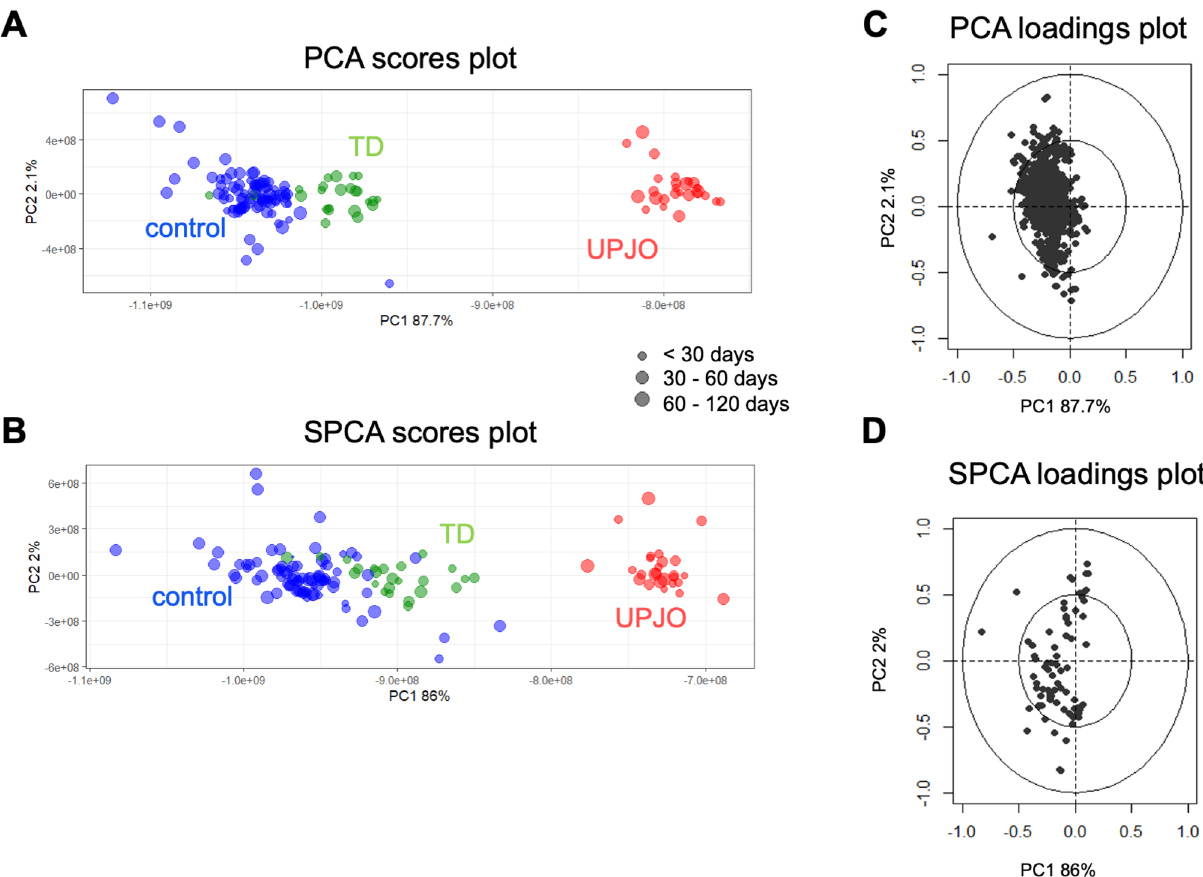
Figure 1. PCA and SPCA analysis of metabolites in urine after 1 H NMR analysis from TD and UPJO patients. ( A ) PCA scores with 87% of the variance explained on the first component and 2.1% on the second component. ( B ) SPCA scores with 86% of the variance explained on the first component and 2.2% on the second component. Fifty variables are selected on each component. SPCA allows the separation between groups. The different groups of samples are represented by colors: control (blue), TD (green), UPJO (red). The size of the dots varies according to the age of the patient in days (10 to 115). ( C ) Loadings plot from PCA with all variables and ( D ) Loadings plot from SPCA with 50 variables on each principal